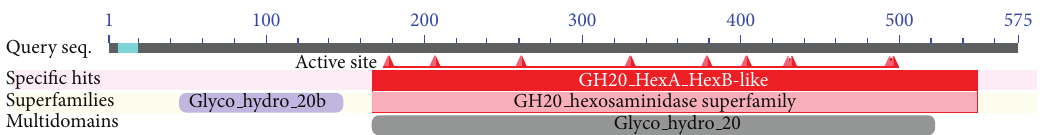
Figure 1: Conserved domains for tomato 𝛽 -hexosaminidase, analyzed using Conserved Domain Database search in NCBI-BLAST.